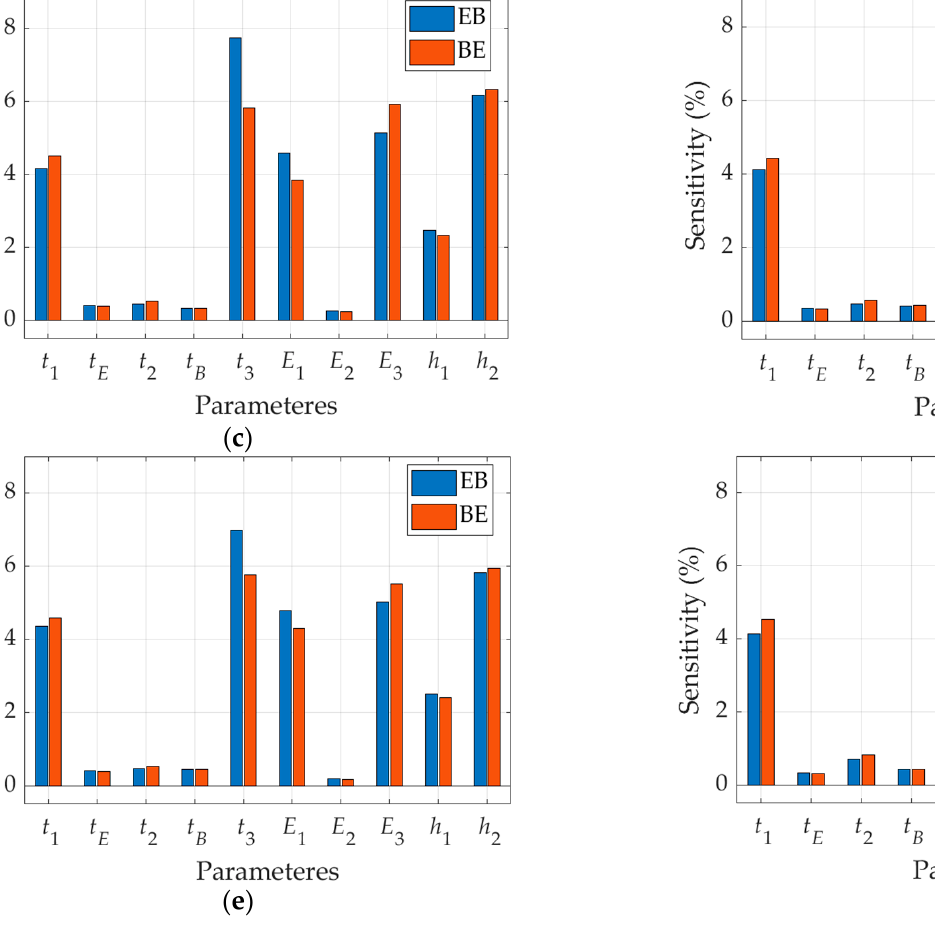
Figure 13. The sensitivity analysis of BS in EB and BE configuration with respect to all layers’ thick- nesses, t i , elastic properties of liners, E i and flute geometric parameters, h i : ( a ) Board 1; ( b ) Board 2; ( c ) Board 3; ( d ) Board 4; ( e ) Board 5; ( f ) Board 6.